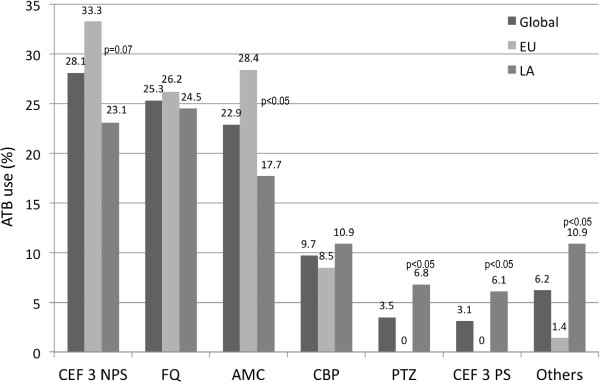
Empiric antibiotic therapy for early ventilator-associated tracheobronchitis. AMC, amoxicillin/clavulanate; AMK, Amikacin; CBP, carbapenem; CEF3 NPS, third-generation non-Pseudomonal cephalosporins; CEF3 PS, third-generation Pseudomonal cephalosporins; EU, European Union group; FQ, fluoroquinolones; LA, Latin American group; PTZ, Piperacillin/Tazobactam; Vanco: vancomycin.